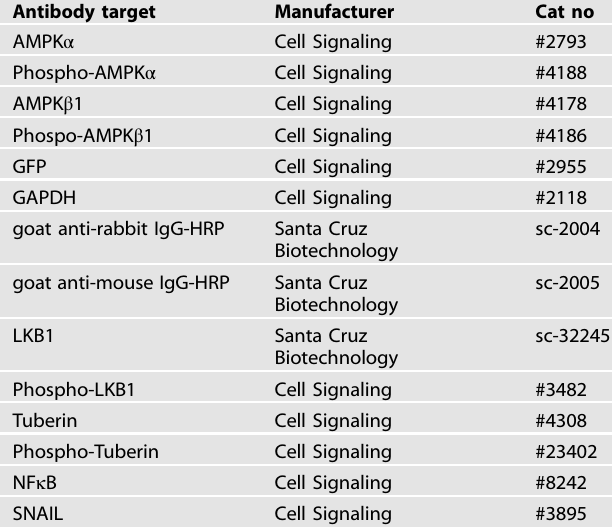
Table 2. Antibodies utilized for protein